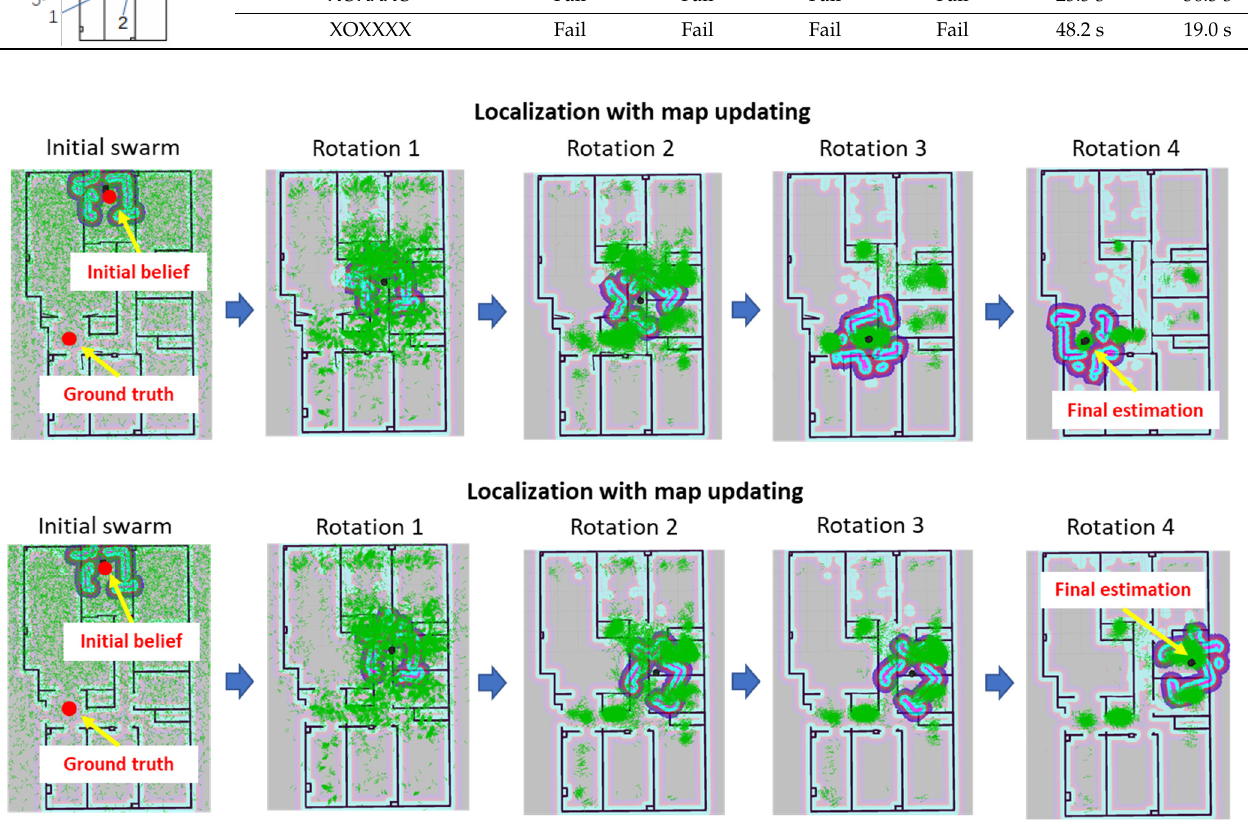
Figure 13. Evolution of particle swarms for actual door configuration OOOOXO using an accurate map (OOOOXO) and inaccurate map (OOOOOO).